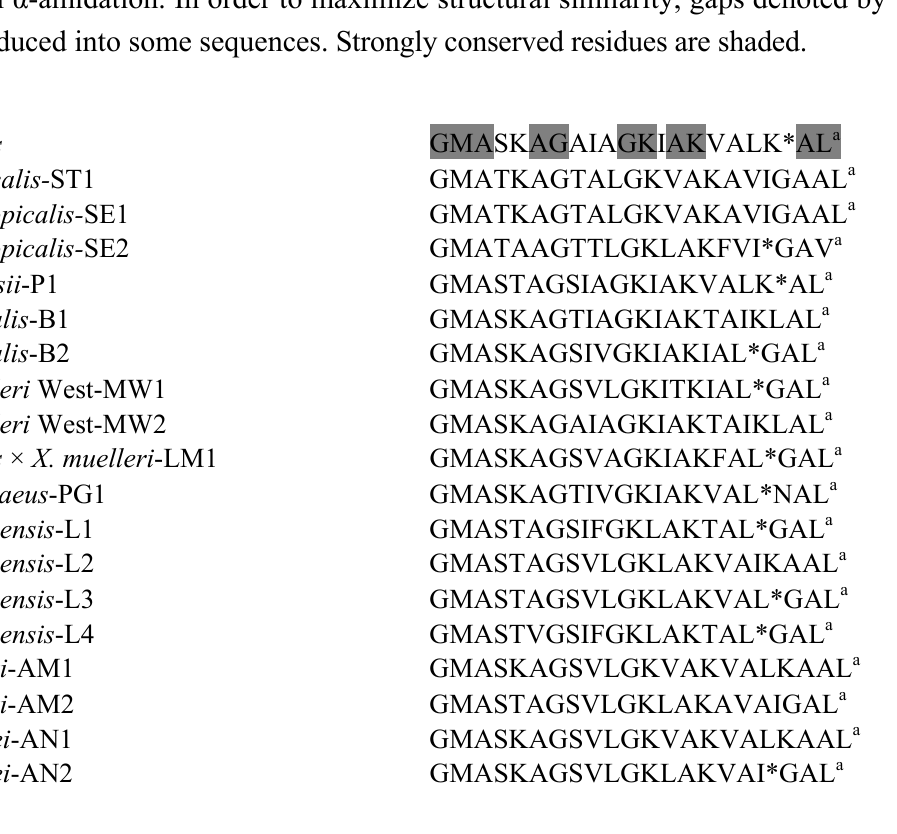
Figure 2. Primary structures of the peptide glycine-leucine-amide (PGLa) peptides isolated from skin secretions of frogs belonging to the genera Xenopus and Silurana . a denotes C-terminal α -amidation. In order to maximize structural similarity, gaps denoted by * have been introduced into some sequences. Strongly conserved residues are